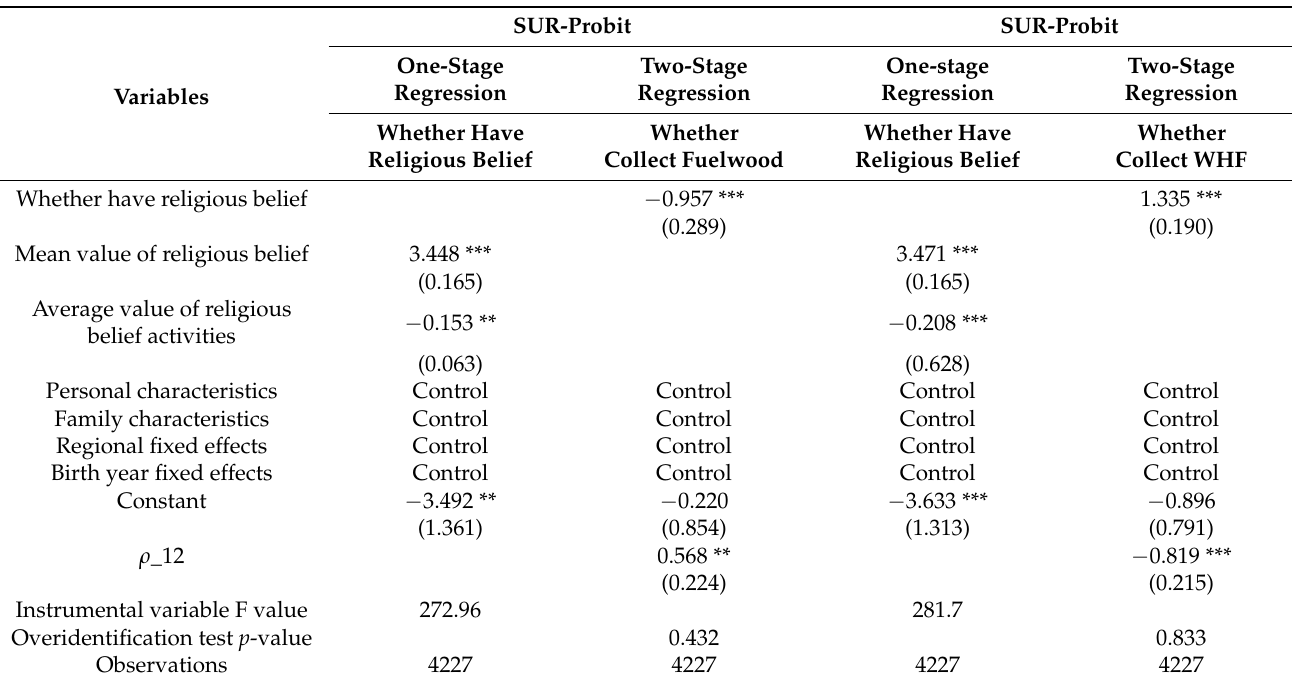
Table 7. The baseline regression for religious beliefs and different NTFPs collection behaviors.